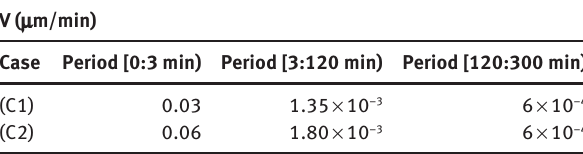
Table 2: Loading details of two situations: (C1) and